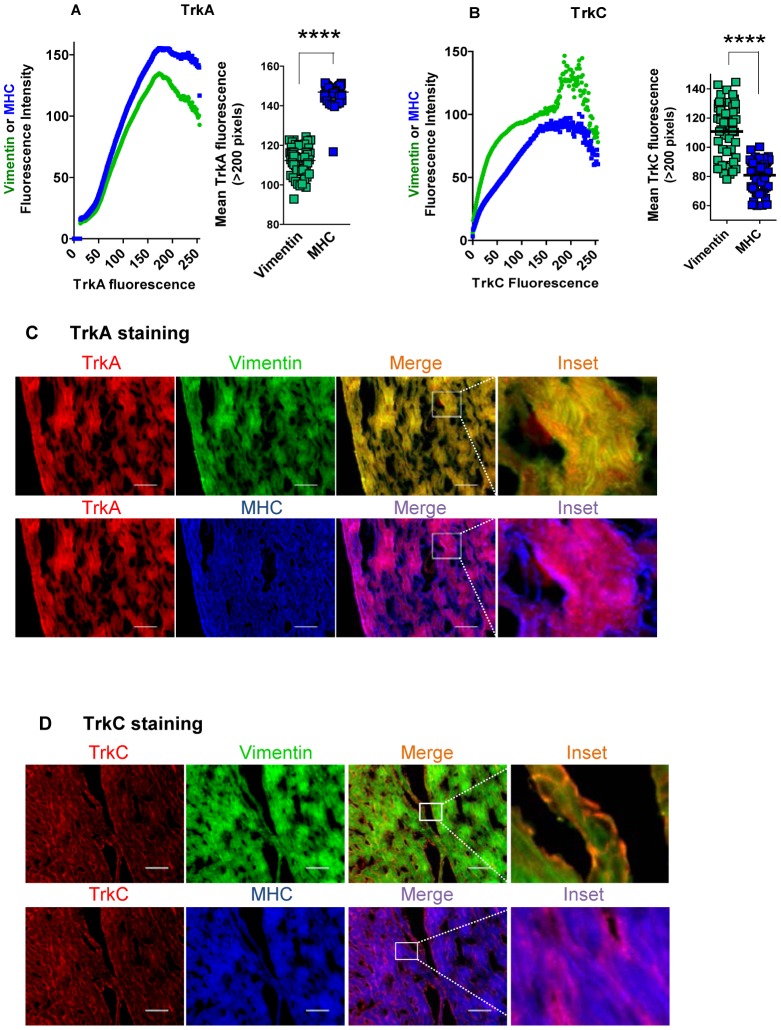
Cardiomyocytes preferentially expresses TrkA and cardiac fibroblasts TrkC.
A) TrkA levels are significantly higher in cardiomyocytes than in cardiac fibroblasts in tissue sections of the heart. Left panel shows the quantification of TrkA, vimentin (cardiac fibroblast marker), and myosin heavy chain (MHC, cardiomyocyte marker) identified by immunofluorescence on sections of C57BL/6 mouse hearts. Vimentin and MHC staining is plotted as function of TrkA fluorescence showing that TrkA is expressed by both cardiac fibroblasts and myocytes and that expression is higher in the myocytes. Right panel is a plot of vimentin and MHC mean fluorescence on pixels where TrkA is >200 (n = 3); ****, p<0.0001. B) TrkC levels are significantly higher in cardiac fibroblasts than on cardiomyocytes in tissue sections of the heart. Left panel shows the quantification of TrkC, vimentin, and MHC identified by immunofluorescence on sections of C57BL/6 mouse hearts, showing a preferential association of TrkC with cardiac fibroblasts. Right panel is a plot of vimentin and MHC mean fluorescence on pixels where TrkC is >200 (n = 3);****, p<0.0001.C) Visualization of the preferential expression of TrkA on cardiomyocytes in the heart. Representative images from the results presented in (A) above. Note preferential merge of TrkA and cardiomyocyte staining, scale bar = 100 µm. D) Visualization of the preferential expression of TrkC in cardiac fibroblasts in the heart. Representative images from the results presented in (B) above. Of note, TrkC staining merges preferentially in vimentin-stained cardiac fibroblasts, typically surrounding cardiomyocyte bundles, scale bar = 100 µm.